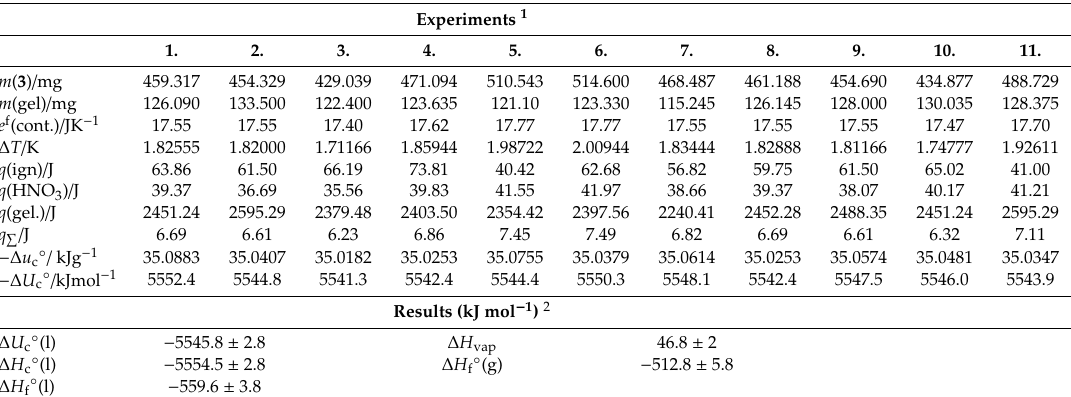
Table 2. Combustion results of 2,4,4,6,6-pentamethyl-1,3-dioxane ( 3 , C 9 H 18 O 2 ). e ◦ (calor.) =